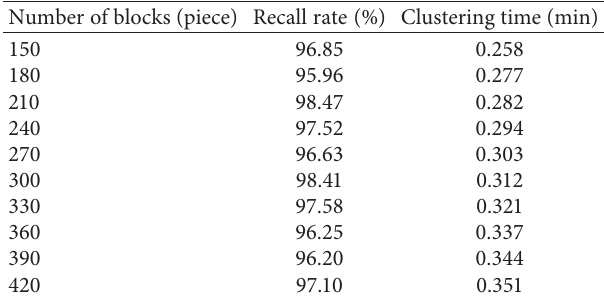
Table 1: The image redundancy processing results of the proposed method.